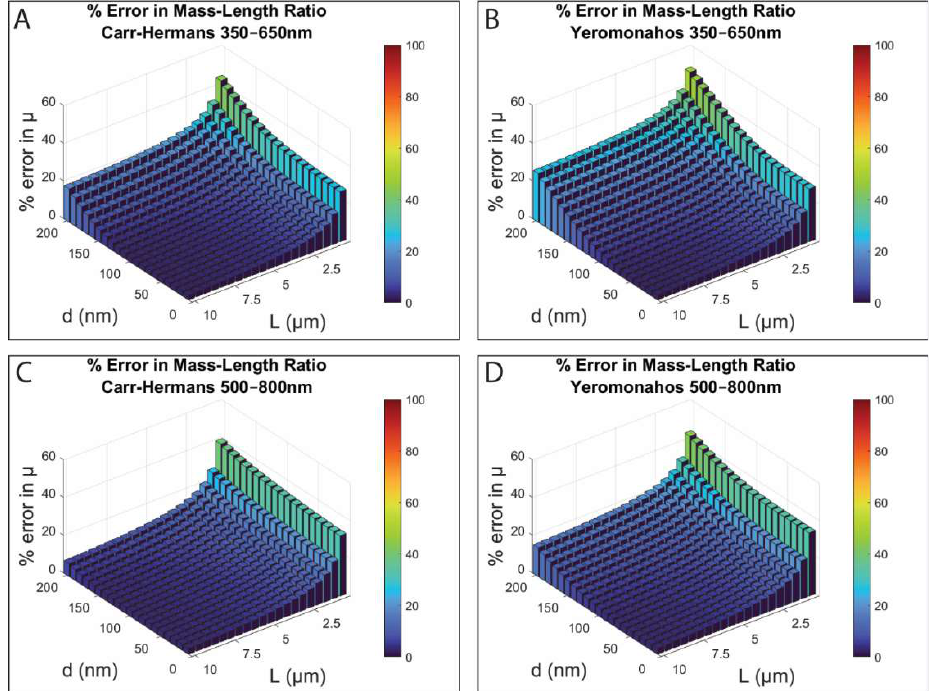
Figure 6. Percent error between the mass–length ratio obtained from fitting the approaches to theoretical turbidity values created using full light scattering theory and the value used to create the initial dataset for lengths of 0.5–10 μm and diameters of 10–200 nm for wavelength ranges of 350–650 nm ( A , B ) and 500–800 nm ( C , D ). (c = 0.0001 g/cm 3 , μ = 4.73 × 10 12 Da/cm, dn/dc and n corrected for wavelength dependence for fibers in HBS buffer).